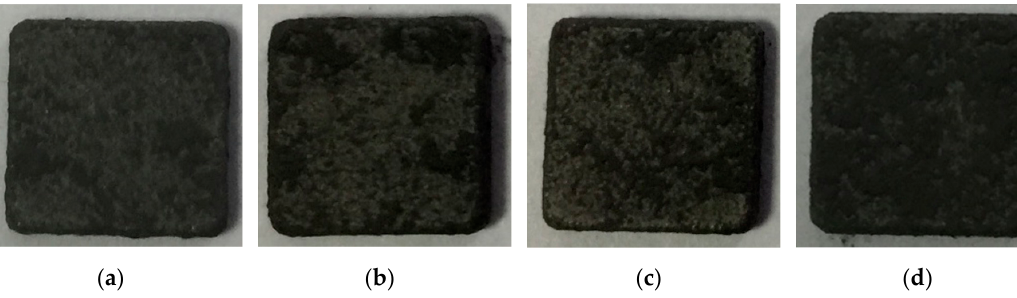
Figure 1. Images of nickel substrates milled with NiAl and CrB 2 powders for: ( a ) 4, ( b ) 8, ( c ) 16, and ( d ) 32 h.